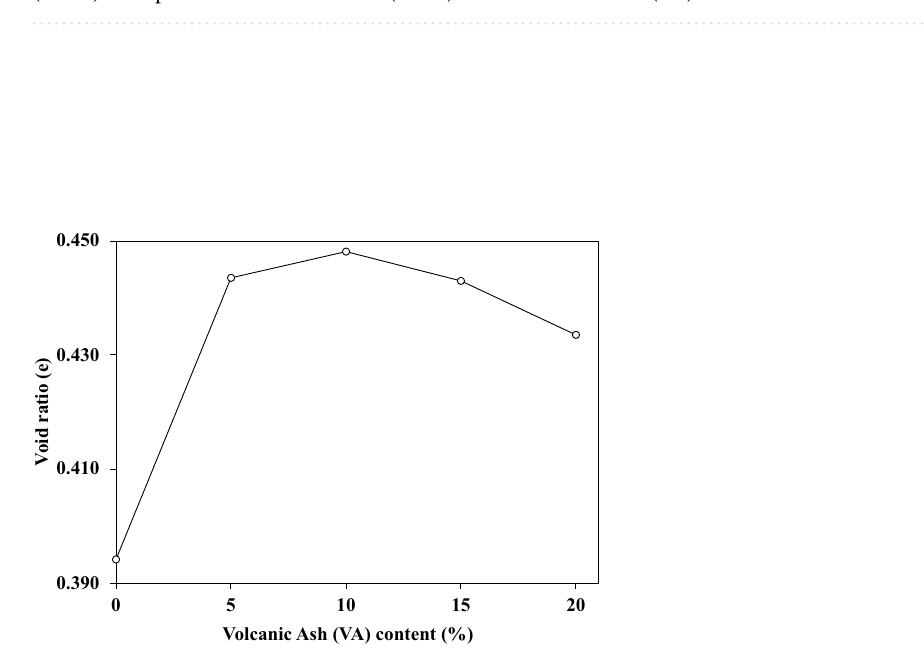
Figure 5. ( a ) Variation of the dry density with the moisture content, ( b ) variation of the maximum dry density (MDD) and optimum moisture content (OMC) with the volcanic ash (VA) content.